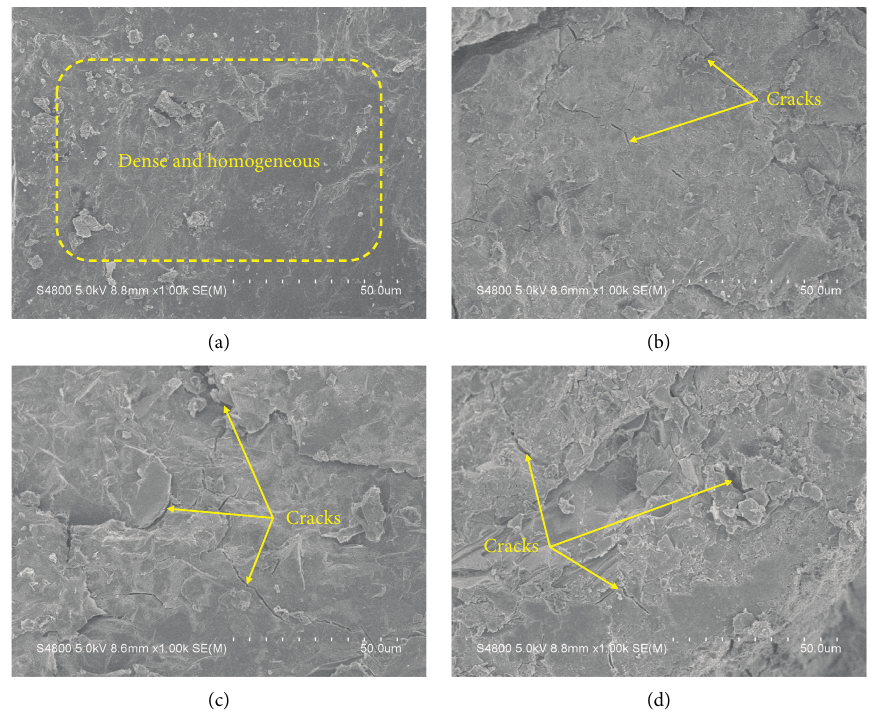
Figure 4: Microstructure of the AASC specimens after different freeze-thaw cycles: (a) 0 cycles; (b) 100 cycles; (c) 200 cycles; (d) 300